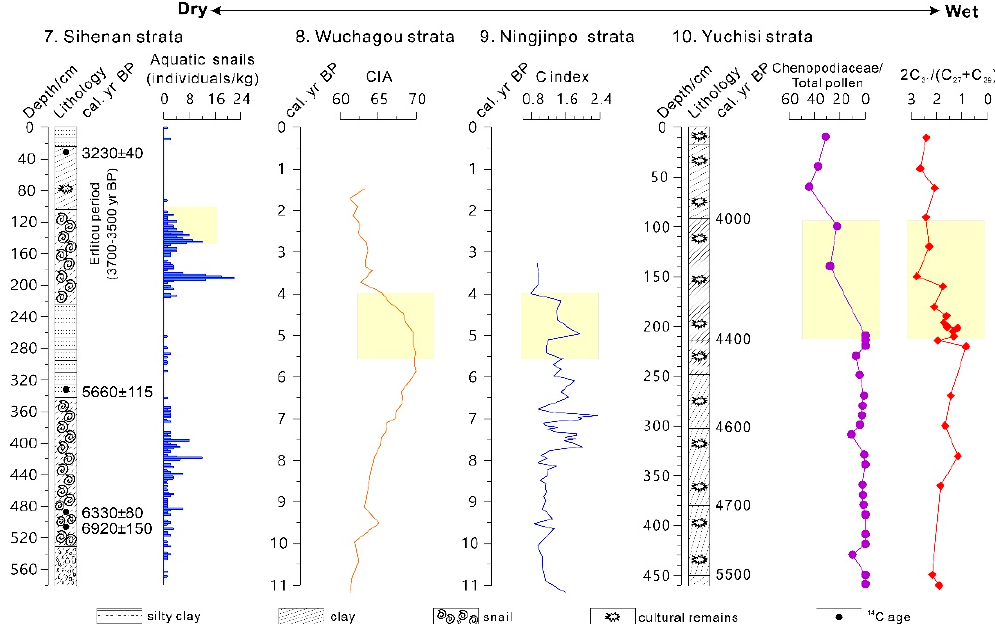
Figure 4. Local paleoenvironmental records in the study area. ( 7 ): The lithology and aquatic snails in Sihenan strata [53,54]; ( 8 ): chemical index of alteration (CIA) value in Wuchagou strata [55]; ( 9 ): C value (also a chemical weathering index to indicate climatic variation) in Ningjinpo strata [56]; ( 10 ) The ratio of Chenopodiaceae to total pollen and the alkane ratio of 2C 31 /(C 27 +C 29 ) in Yuchisi strata [57].